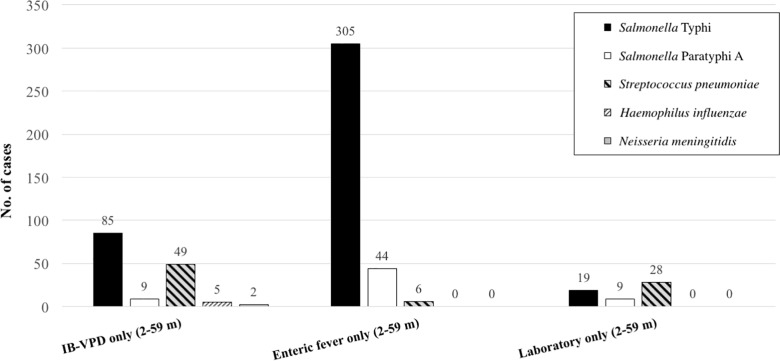
Predominant bacterial etiologies isolated in the hospital and laboratory surveillance systems.